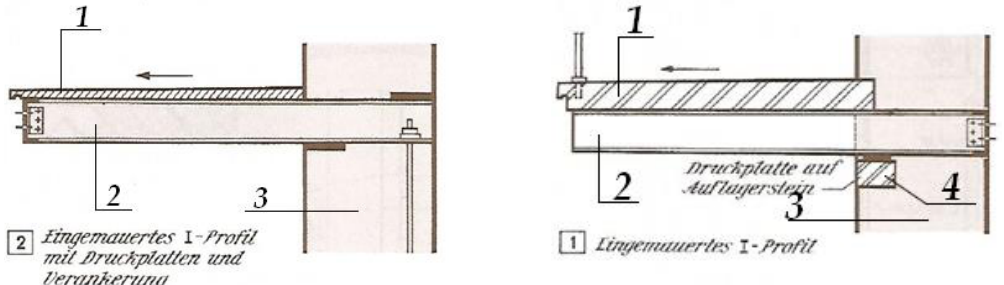
Figure 11. Concepts of supporting balconies using steel beams [30]: (1) concrete slab on steel beams; (2) cantilever steel beam; (3) brick wall; (4) support stone.